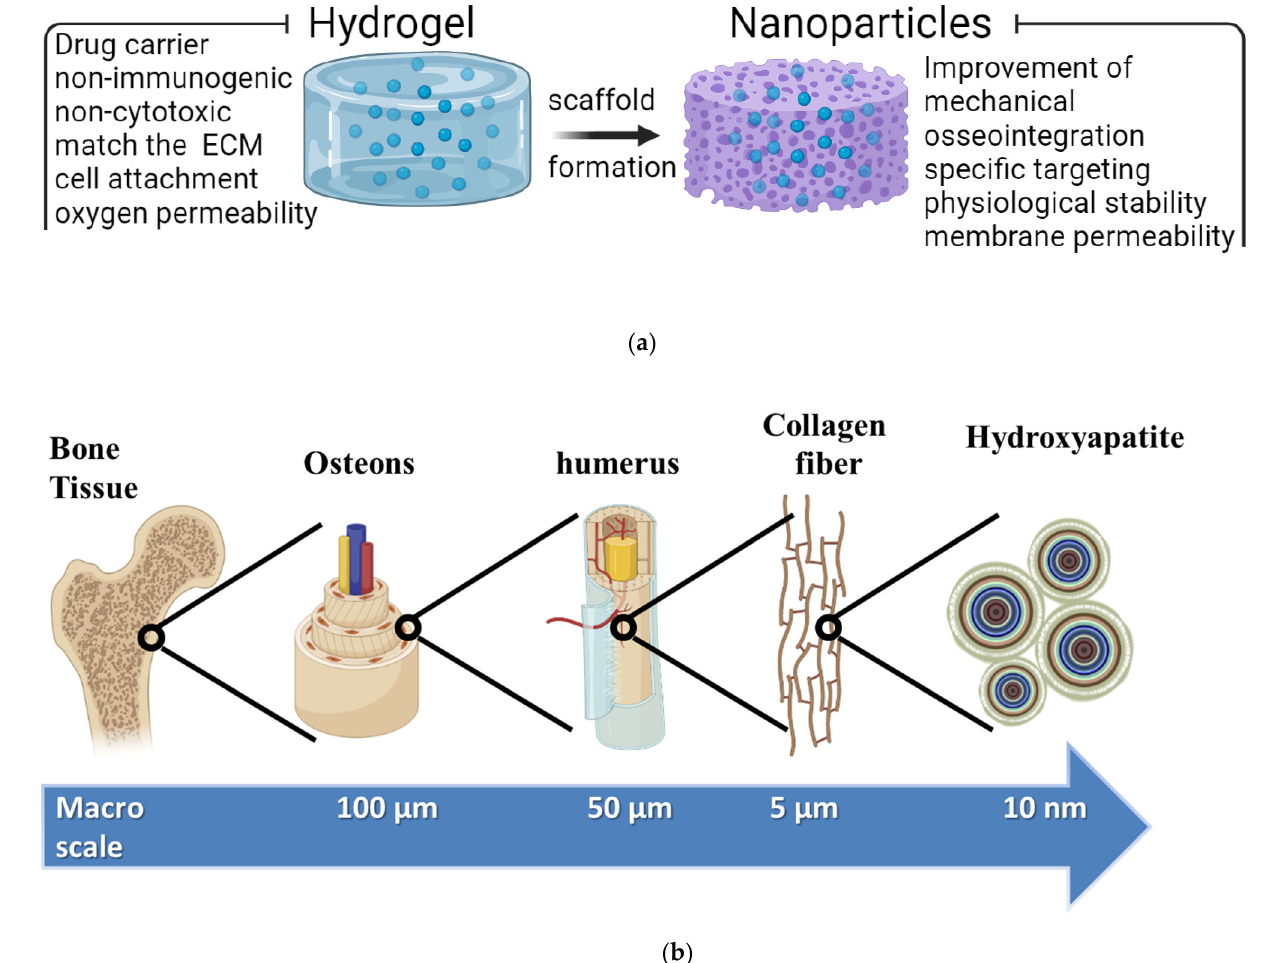
Figure 2. ( a ) Superstructures of a nanoparticle–polysaccharide hydrogel for a tissue engineering scaffold. Nanoparticle–polysaccharide hydrogel systems combine the distinct benefits of their constituent components, allowing them to excel in drug delivery, immunological regulation, detoxification, and tissue engineering, among other uses. ( b ) The hierarchical structure of a bone ranging from microscale skeleton to nanoscale collagen and hydroxyapatite. Table 3. Advantages of a nanoparticle–polysaccharide hydrogel for biomedical uses [90]. Application